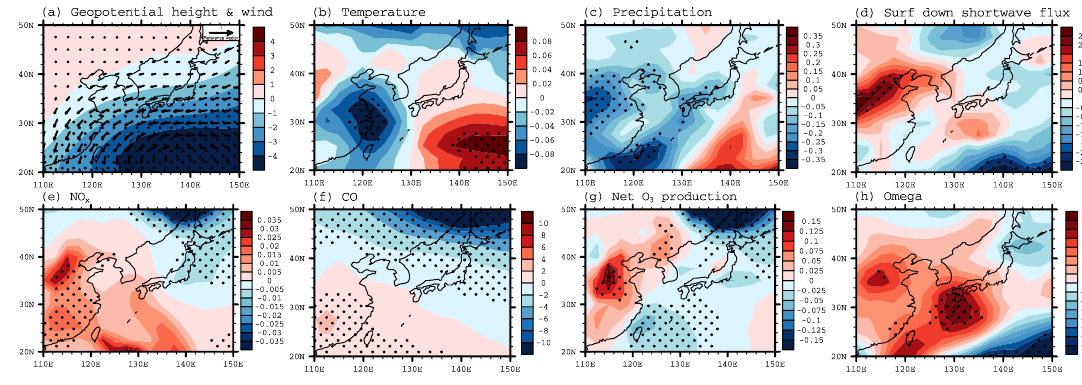
Figure 8. Same as Figure 6, except for PC2 time series.